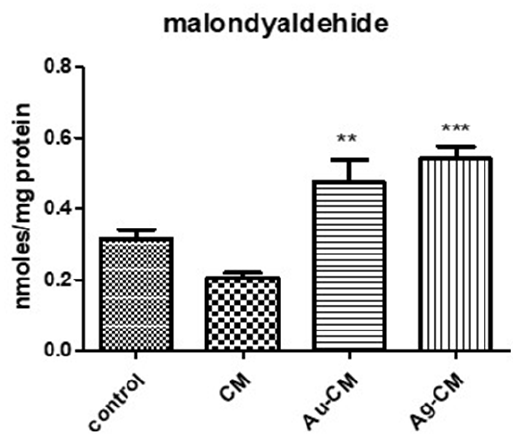
Figure 12. Malondyaldehide in DLD-1 cells after treatment with CM extract, Au-CM and Ag-CM. DLD-1 cells were treated with 40 µ g/mL CM extract, 40 µ g/mL Au-CM, and 4 µ g/mL Ag-CM for 24 h, and then MDA levels were assessed using the ELISA kit. Statistical analysis was performed with one-way ANOVA and Bonferroni’s posttest (** p < 0.01, *** p < 0.001 compared to control cells).